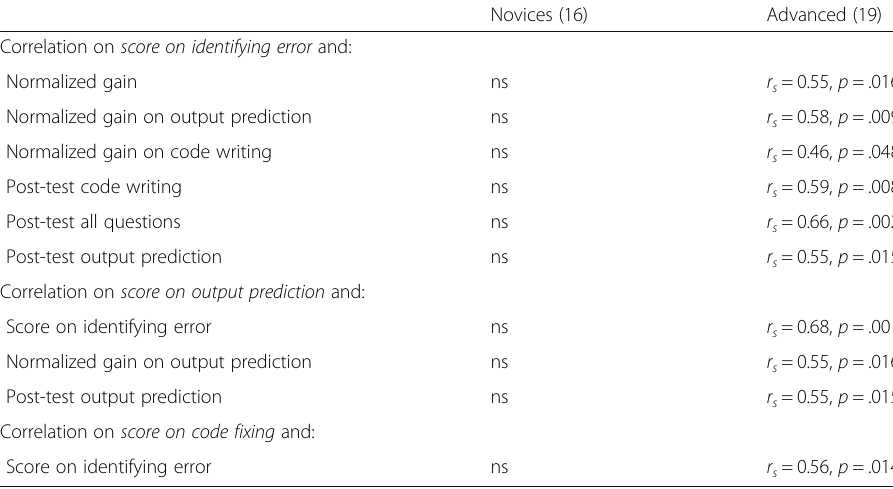
Table 6 Spearman ’ s correlations between scores, post-test and normalized gains ( ns denotes not